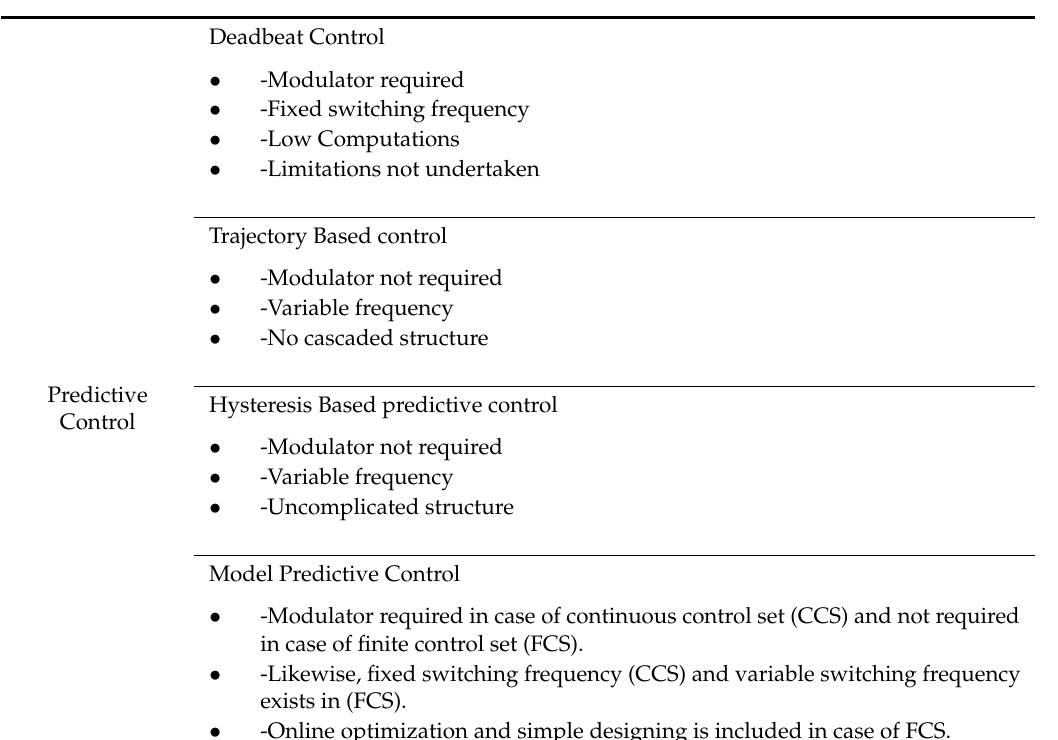
Table 2. Description of predictive controllers on the basis of their pros. &